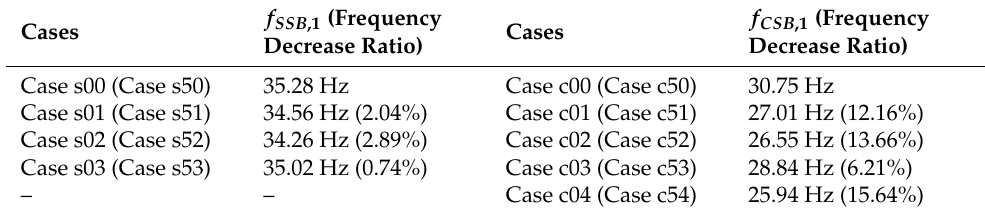
Table 3. Influence of added mass on the fundamental